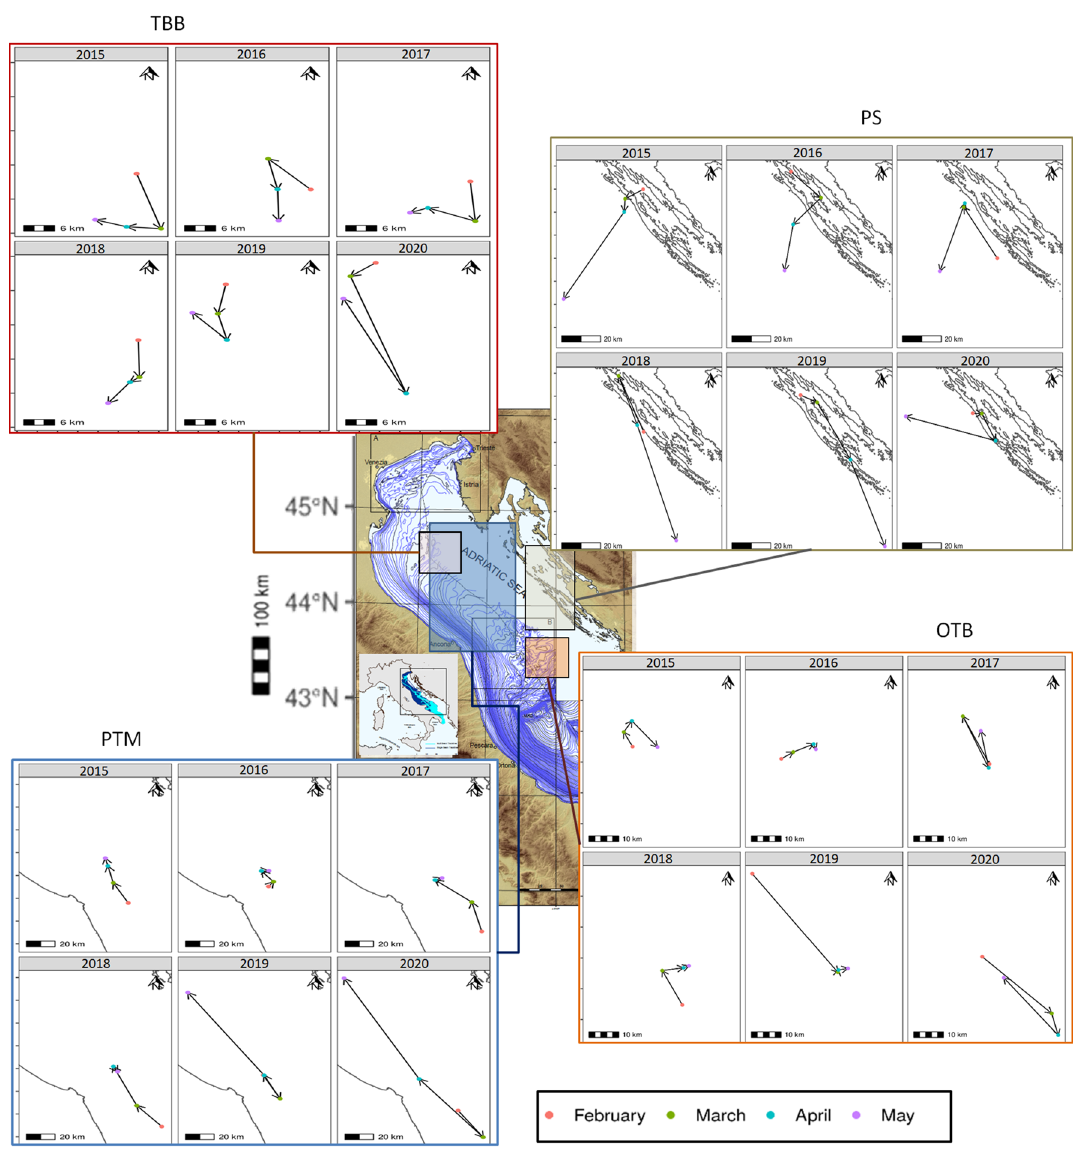
Figure 4. Distribution of the annual barycentre shifts over February and May between 2015 and 2020, reported per estimated fishing gear. The coloured bounding boxes depict the maximum extents of the barycentre movements. Acronyms refer to distinct fleets using purse seines (PS), pelagic pair trawls (PTM), beam trawls (TBB) or bottom otter trawls (OTB). The underlying bathymetry map belongs to a previous work 43 of co-author F. Trincardi. Barycentre shift visualisation was realised with R v.4.1.2 (https:// cran.r- proje ct. org/ bin/ windo ws/ base/) using the ggplot2 v.3.3.5, cowplot v.1.1.1, and raster v.3.5.2